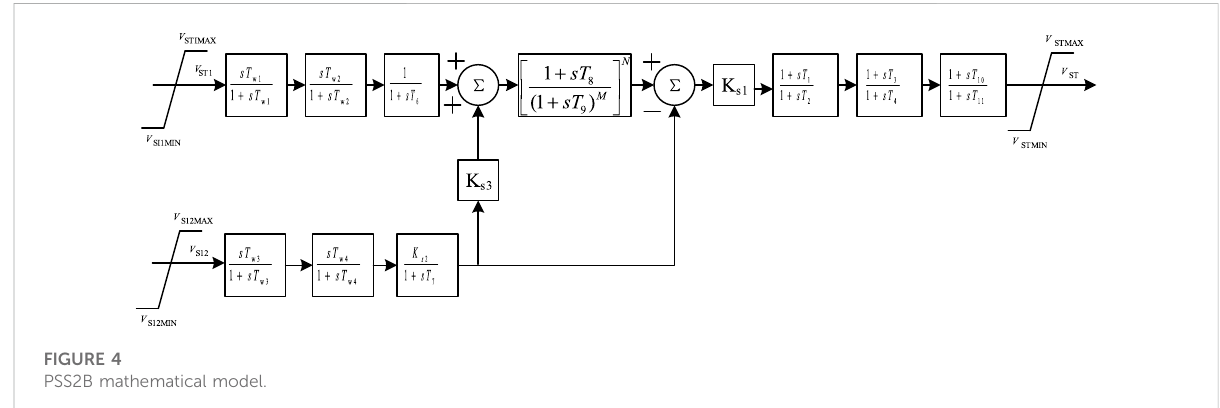
FIGURE 4 PSS2B mathematical